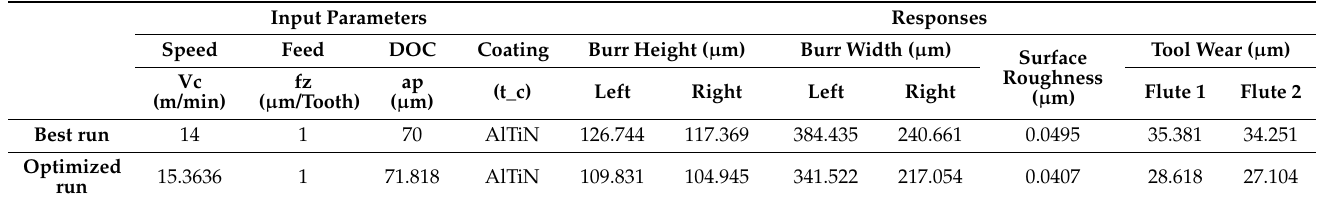
Table 7. Comparison of optimized run with best initial experimental run.